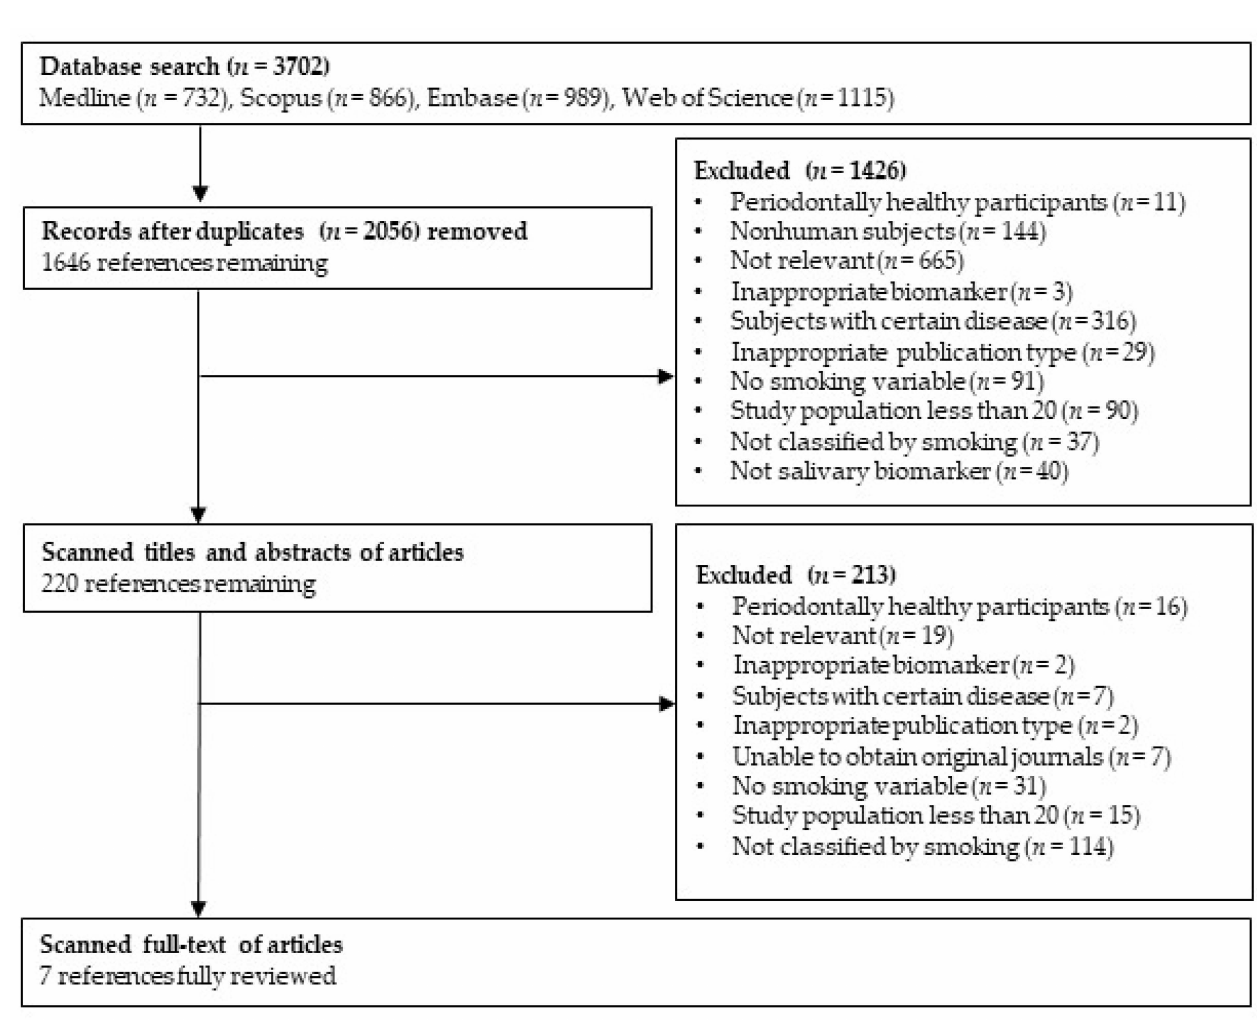
Figure 1. Flow diagram of the literature search